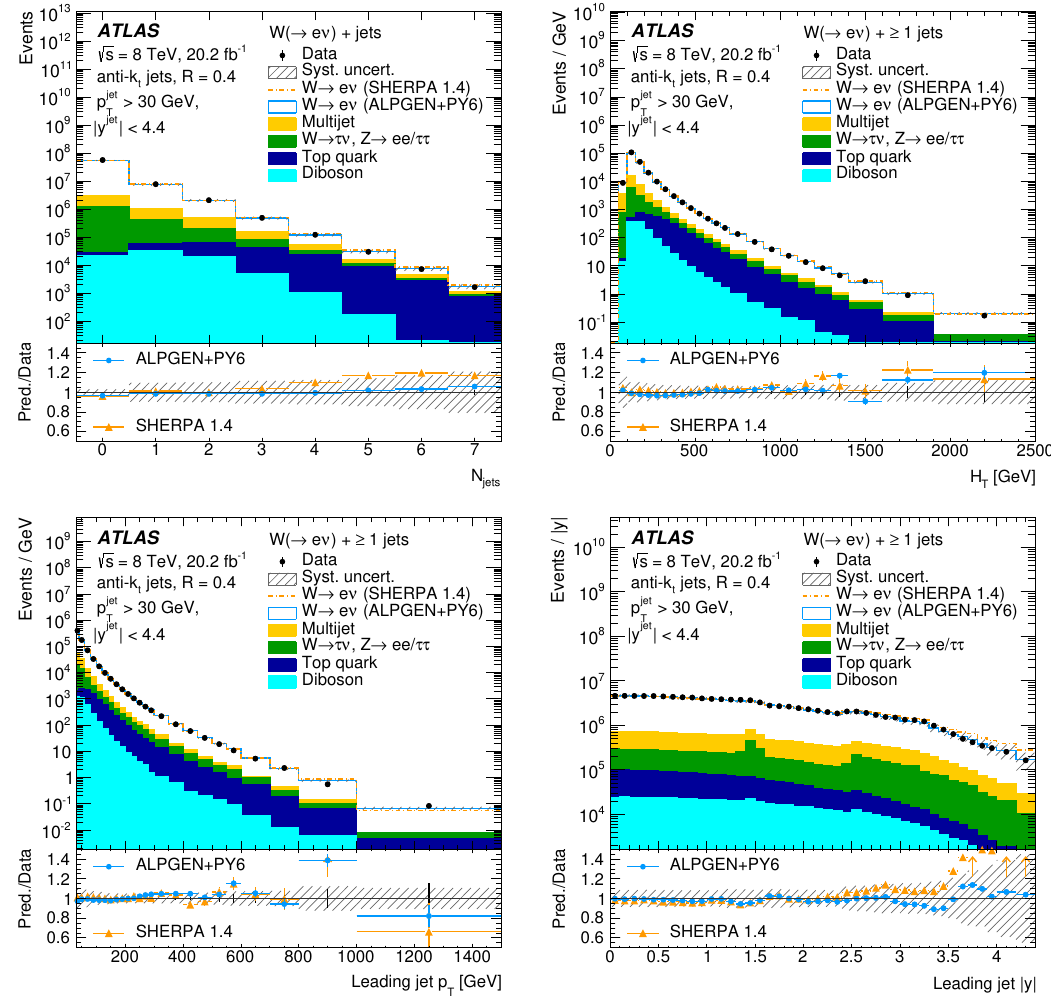
Figure 1 . Distribution of events passing the W + jets signal selection as a function of the exclu- sive jet multiplicity (upper left), the H T (upper right), the leading jet’s p T (lower left), and the leading jet’s rapidity (lower right). The lower panels display the ratio of the predictions for signal plus background to data using either Alpgen + Pythia 6 (blue) or Sherpa 1.4 (orange) as the signal simulation. The statistical uncertainty of the data is shown as black error bars and the total uncertainty in the prediction as the hatched band. The latter consists of the systematic uncer- tainties, including the uncertainty due to the luminosity, and the statistical uncertainties from the predictions and the data-driven multijet